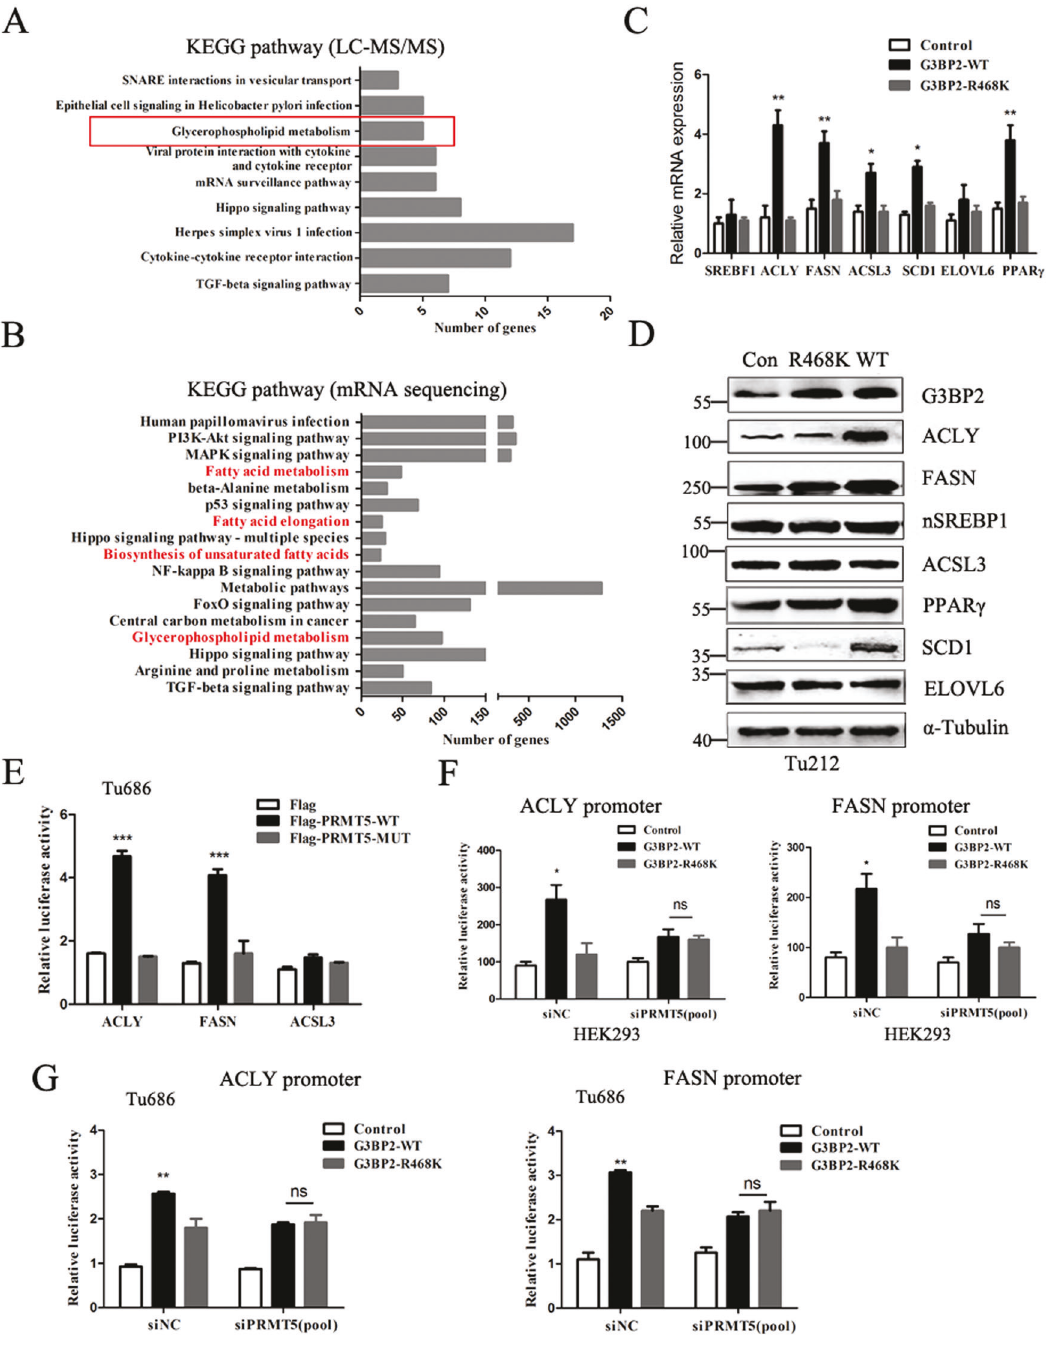
Fig. 4 Methylation of G3BP2 by PRMT5 confers lipid metabolism reprogramming. A The KEGG pathway analysis of the lipid metabolism- associated pathway affected by G3BP2 in Tu212 cells. B The KEGG pathway enrichment analysis of G3BP2-conferred metabolism pathways in Tu212 cells. C The effect of G3BP2-WT or G3BP2-R468K on the expression of lipid metabolism-associated genes were measured by RT-PCR analysis in Tu212 cells. D The effect of G3BP2-WT and G3BP2-R468K on the lipid metabolism-associated proteins were measured by immunoblotting analysis. E ACLY and FASN luciferase activity were determined by co-transfected with PRMT5-WT/PRMT5-MUT and pSV- Renilla to Tu686 cells. Luciferase activities were measured 60 h later. ACSL3 gene was used as an negative control. F , G The G3BP2-WT or G3BP2- R468K along with ACLY and FASN luciferase reporter plasmids were co-transfected into HEK293 or Tu686-PRMT5(KO) cells for 60 h. The luciferase activities were analyzed by dual-luciferase reporter assay, and normalized to the activity of Renilla. The data are presented as the mean ± SD; ns no signi fi cant difference; * P < 0.05; ** P < 0.01,*** P < 0.001. Supplementary Fig. S4C, D). Consistent with that, co-transfection that lipid droplets formation were dramatically decreased and less of G3BP2-WT along with PRMT5 enhanced the levels of lipid abundant when G3BP2 inhibition in Tu686 and CAL-27 cells, while droplets, suggesting that methylation of G3BP2 R468 was required there were more lipid droplets formation in PRMT5(KO)-Tu686 and for PRMT5-G3BP2 complex mediated accumulation of lipid CAL-27 cells with G3BP2 overexpression (Fig. 5C, D and